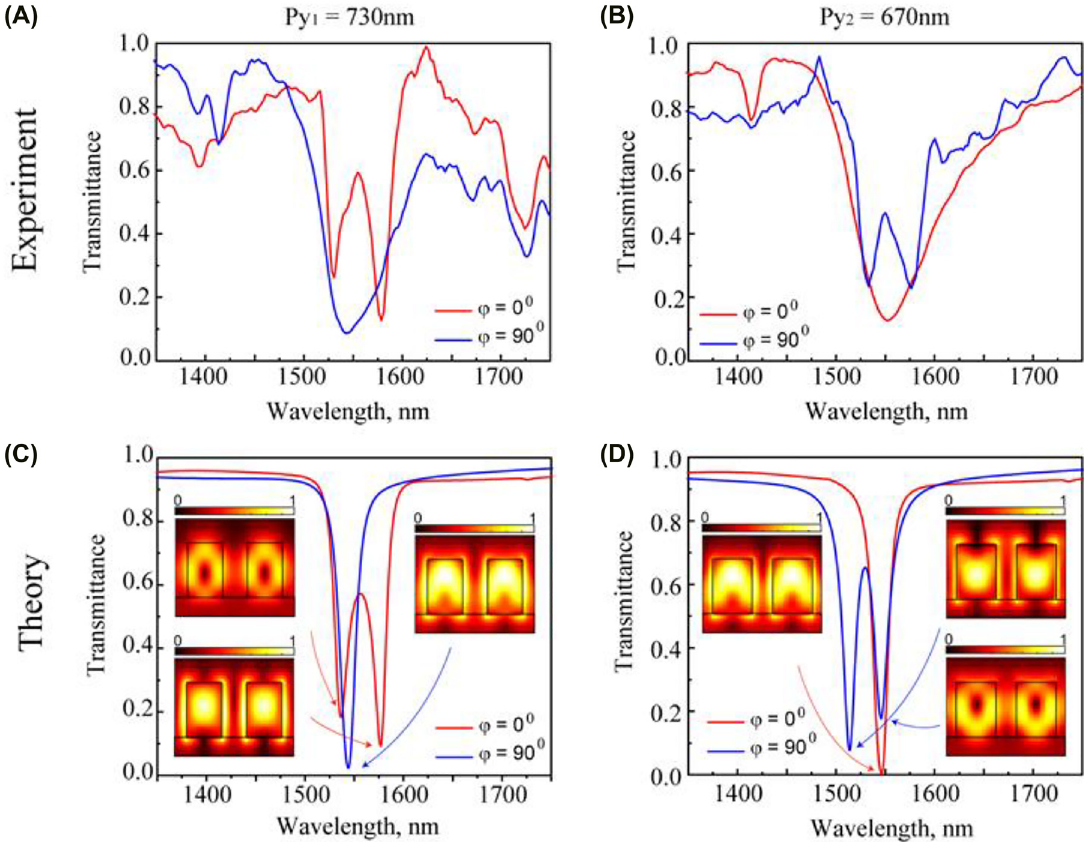
Figure 2: Measured normalized (A, B) and numerically calculated (C, D) transmittance spectra for two samples after NLC infiltration with the = 730 nm (A, C) and P = 670 nm (B, D). Red lines denote the resonance positions when applied magnetic field B is along the periods P y y 2 1 x -axis ( 𝜑 = 0 ◦ ) while blue lines correspond to the case when B is along the y -axis ( 𝜑 = 90 ◦ ). The insets in (C, D) show the amplitude of electric field profiles of QBIC